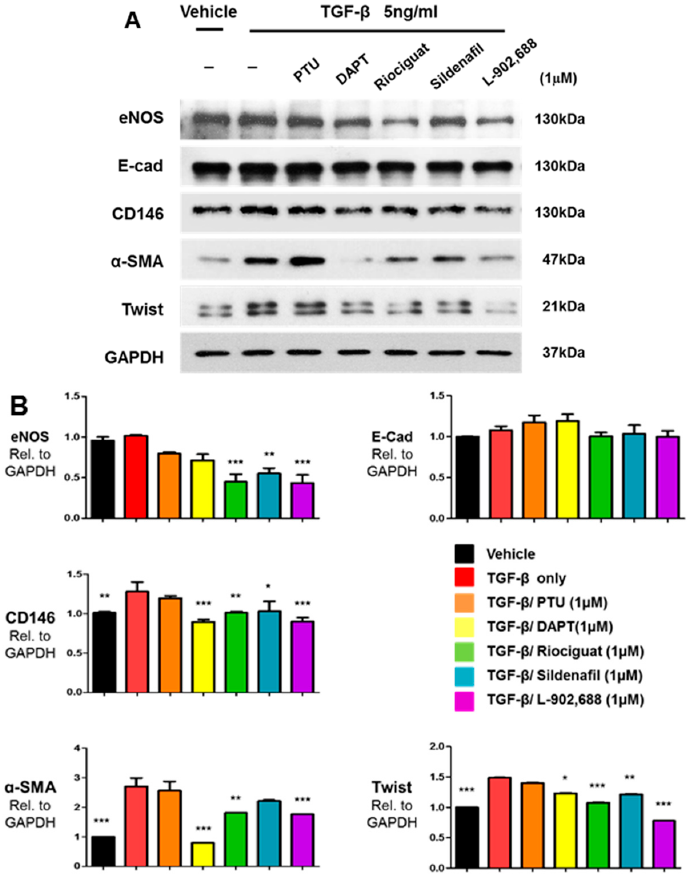
Figure 1. Effect of pulmonary arterial hypertension (PAH) drug candidates on endothelial cell markers and mesenchymal cell markers in cultured endothelial cells. ( A ) Representative immunoblot and ( B ) densitometric quantification of Western blot shows the expression levels of endothelial cell markers eNOS, E-cadherin (E-cad) and CD146, and mesenchymal cell markers Twist and α -smooth muscle actin ( α -SMA) in whole cell extract. Human umbilical vein endothelial cells (HUVECs) were treated under the indicated conditions for 24 h. The relative expression level of each protein was quantified by densitometry and normalized to GAPDH. Each value represents the mean ± SE of three independent experiments. * p < 0.05, ** p < 0.01, and *** p < 0.001 versus the TGF- β 1-only group (the red bar) by one-way ANOVA with Bonferroni’s post-test.